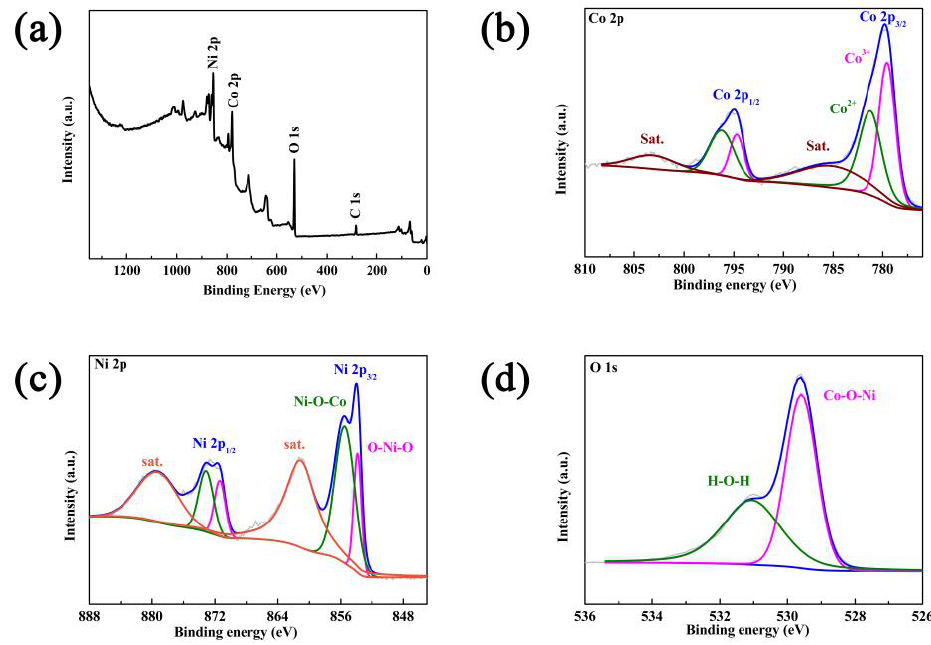
Figure 10. ( a ) Survey spectrum, ( b ) Co 2p, ( c ) Ni 2p and ( d ) O 1s for CoNiO 2 post-HER of XPS spec- tra.